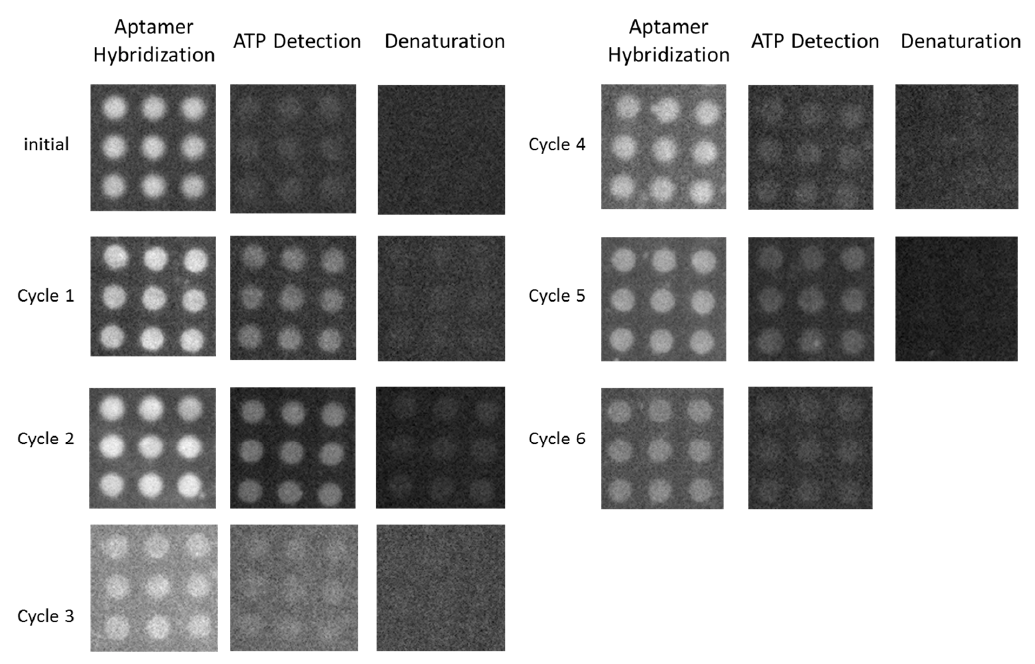
Figure 9. Fluorescence intensity variation during aptasensor reuse over two weeks.